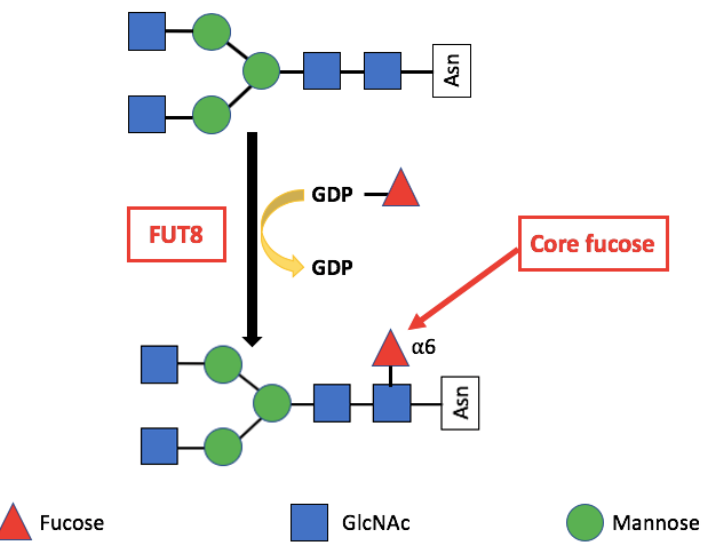
Figure 1. The reaction catalysed by FUT8. FUT8 transfers an L -fucose reside from GDP-β- L -fucose (GDP-Fuc) onto the innermost GlcNAc of an N-glycan to form an α-1,6 linkage.